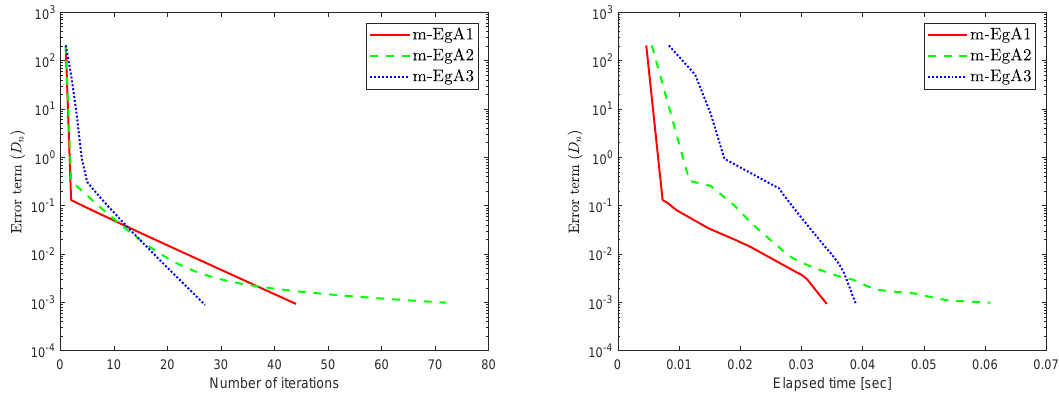
Figure 9. Numerical behaviour of Algorithm 1 compared to Algorithm 1 in [30] and Algorithm 2 in [30] for Example 1, when u 0 = t